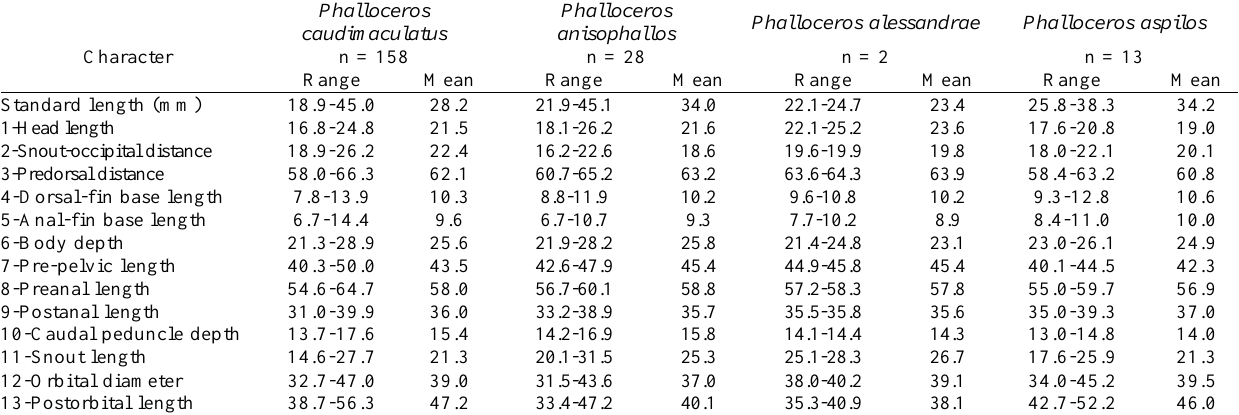
Table 5. Descriptive morphometrics of female specimens of Phalloceros caudimaculatus , P . anisophallos , P . alessandrae , and P . aspilos . Measurements 1-10 are percents of standard length and measurements 11-13 are percents of head